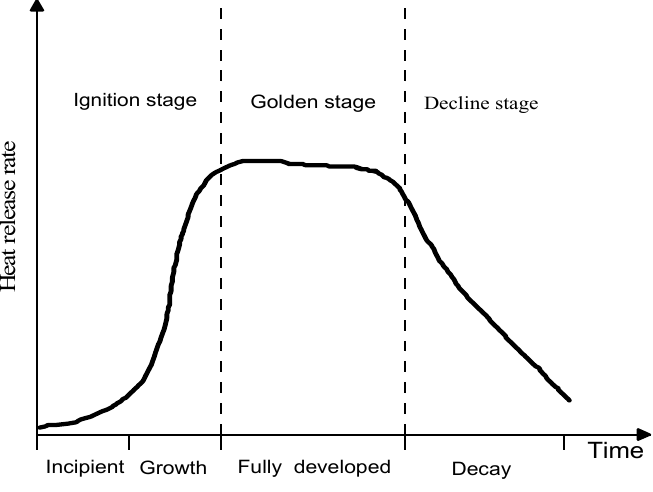
Figure 1. Fire development process.